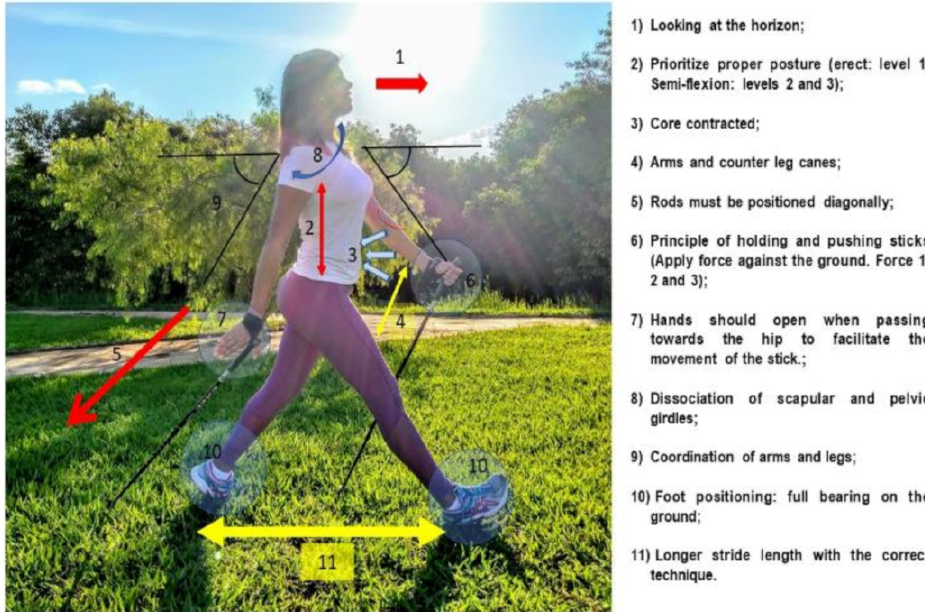
Figure 2. Four-support system of Nordic walking: Brazil Locomotion